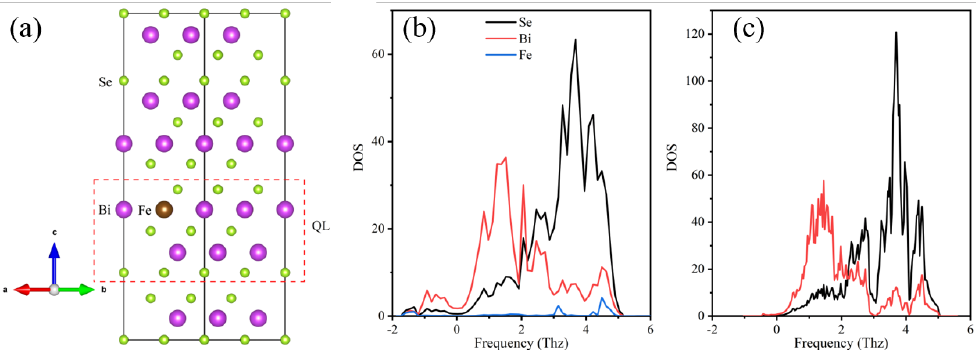
Figure 5. ( a ) The 60-atom layered crystal structure of Fe-doped Bi 2 Se 3 ; ( b ) the phonon state density of Fe-doped Bi 2 Se 3 ; and ( c ) the phonon state density of Bi 2 Se 3 . (Note: the black line shows the phonon state density of Se atoms; the red line shows the phonon state density of Bi atoms; the blue line shows the phonon state density of Fe atoms.).